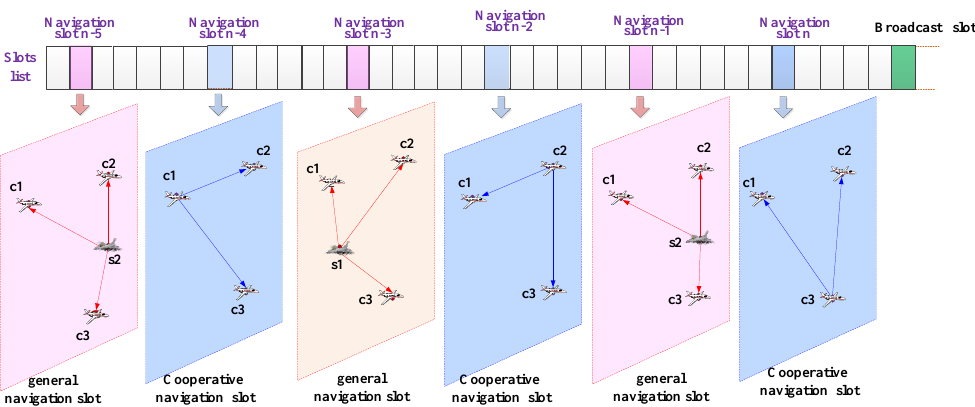
Figure 6. Relationship of navigation slots and measurements relation. The information computing center unit used to compute is divided into two parts.